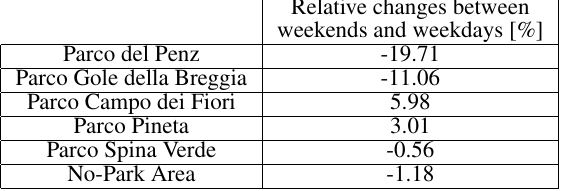
Table 1. Relative changes [%] of average users’ population between weekends and weekdays.